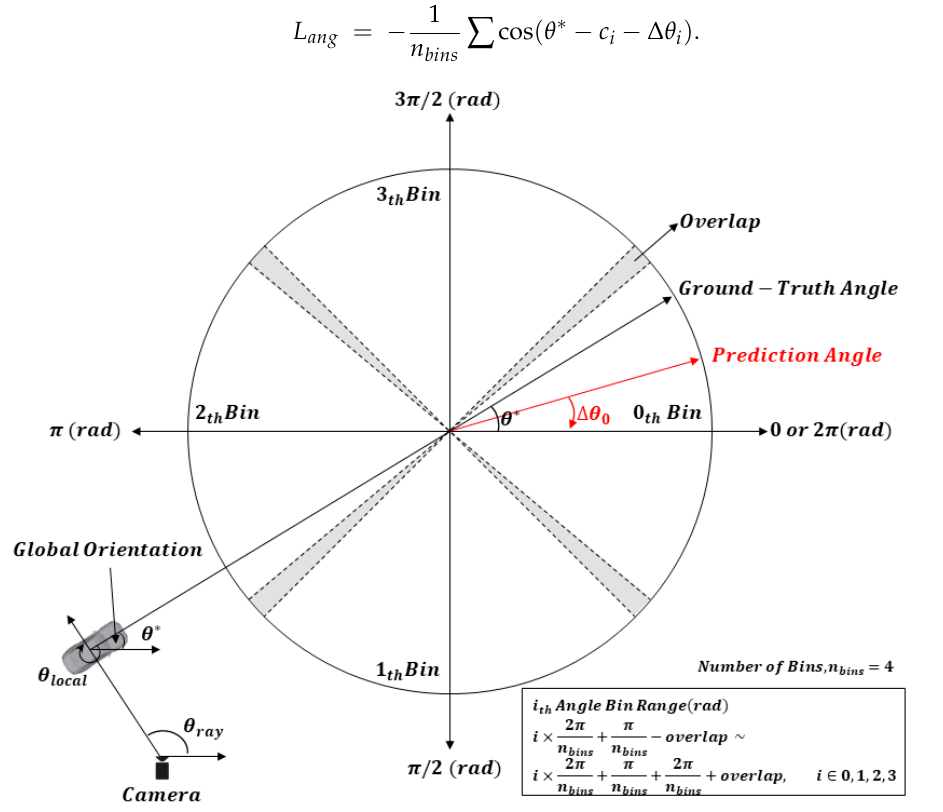
Figure 7. MultiBin structure for orientation estimation (number of bins = 4).